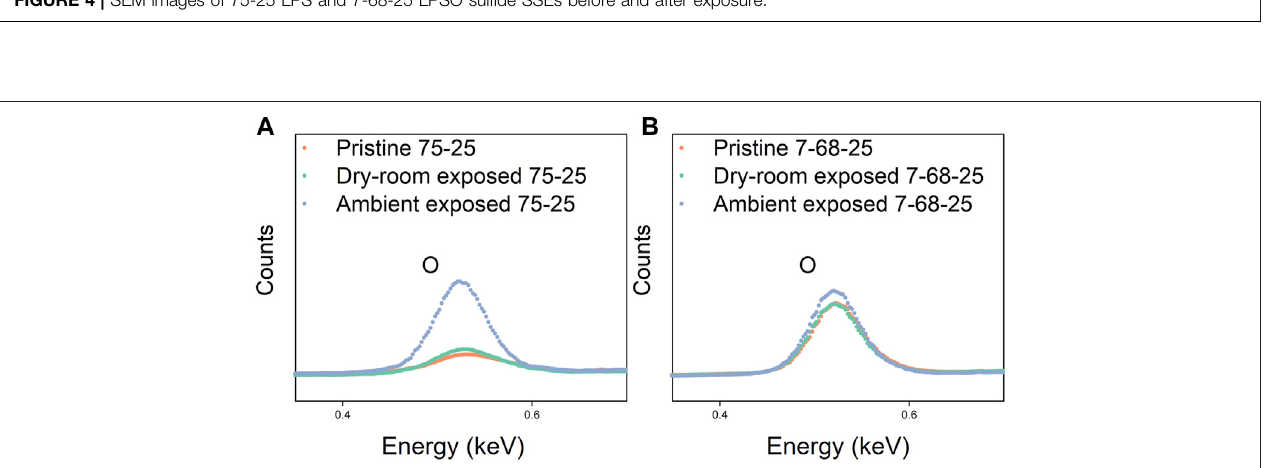
FIGURE 5 | EDS oxygen K α principle line (0.52 keV) for 75-25 LPS (A) and 7-68-25 LPSO (B) before (red) and after exposure to either a dry room environment (green) or ambient air (blue).